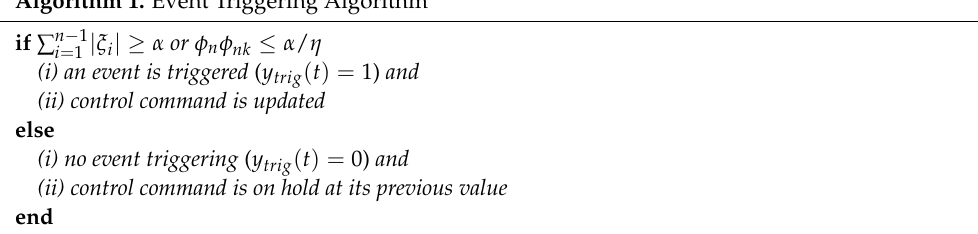
Algorithm 1. Event Triggering